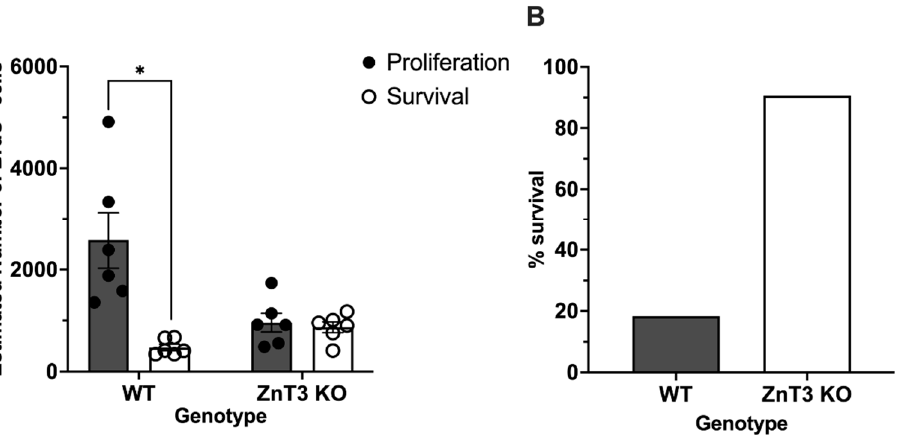
Figure 7. Proliferation and survival of cells labelled at P14, as measured by BrdU + cells, in male WT and ZnT3 KO mice. BrdU was administered to male WT and ZnT3 KO mice on P14 to label dividing cells ( n = 6 per group). To assess cell proliferation, brains were collected approximately 24 h after the last injection. To assess cell survival, brains were collected on P60. BrdU + cells were counted in the SGZ and GCL. ( A ) Male WT mice had significantly higher numbers of BrdU + cells at P14 compared to at P60. In contrast, the number of BrdU + cells at P14 and P60 did not differ for male ZnT3 KO mice. ( B ) In male WT mice, 18.37% of cells labelled at P14 survived to P60. In male ZnT3 KO mice, 90.61% of cells labelled at P14 survived to P60. Error bars represent ± standard error of the mean. * Indicates p <